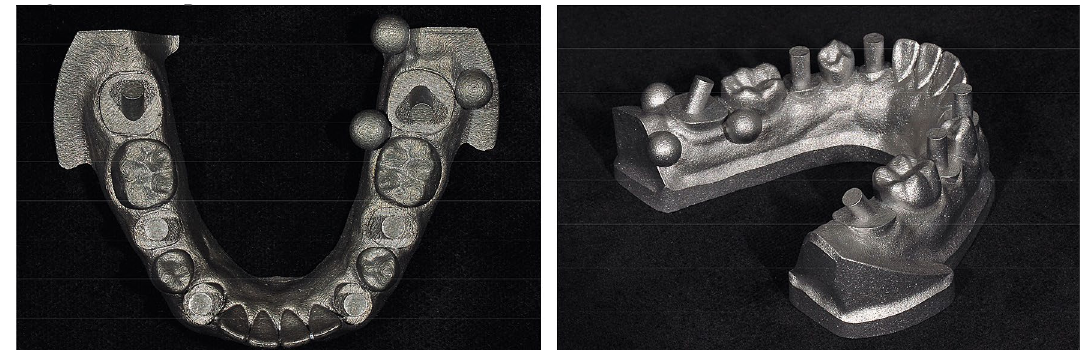
Figure 1. 3D printed Co–Cr master model.